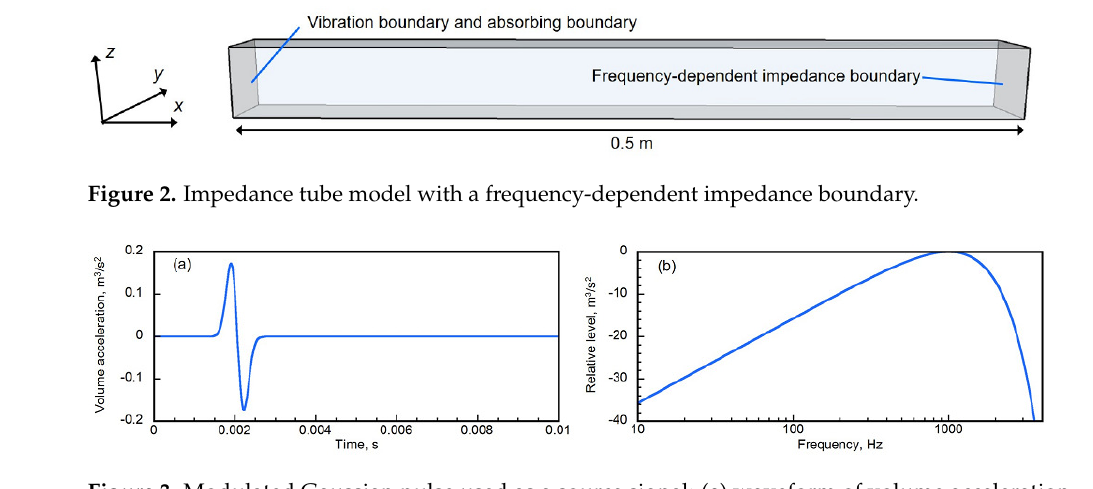
Figure 3. Modulated Gaussian pulse used as a source signal: ( a ) waveform of volume acceleration and ( b ) spectrum